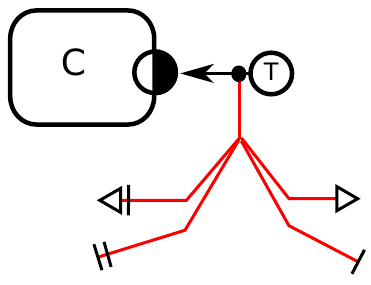
Figure 2.46: Multiple synchronous consequences of the event.